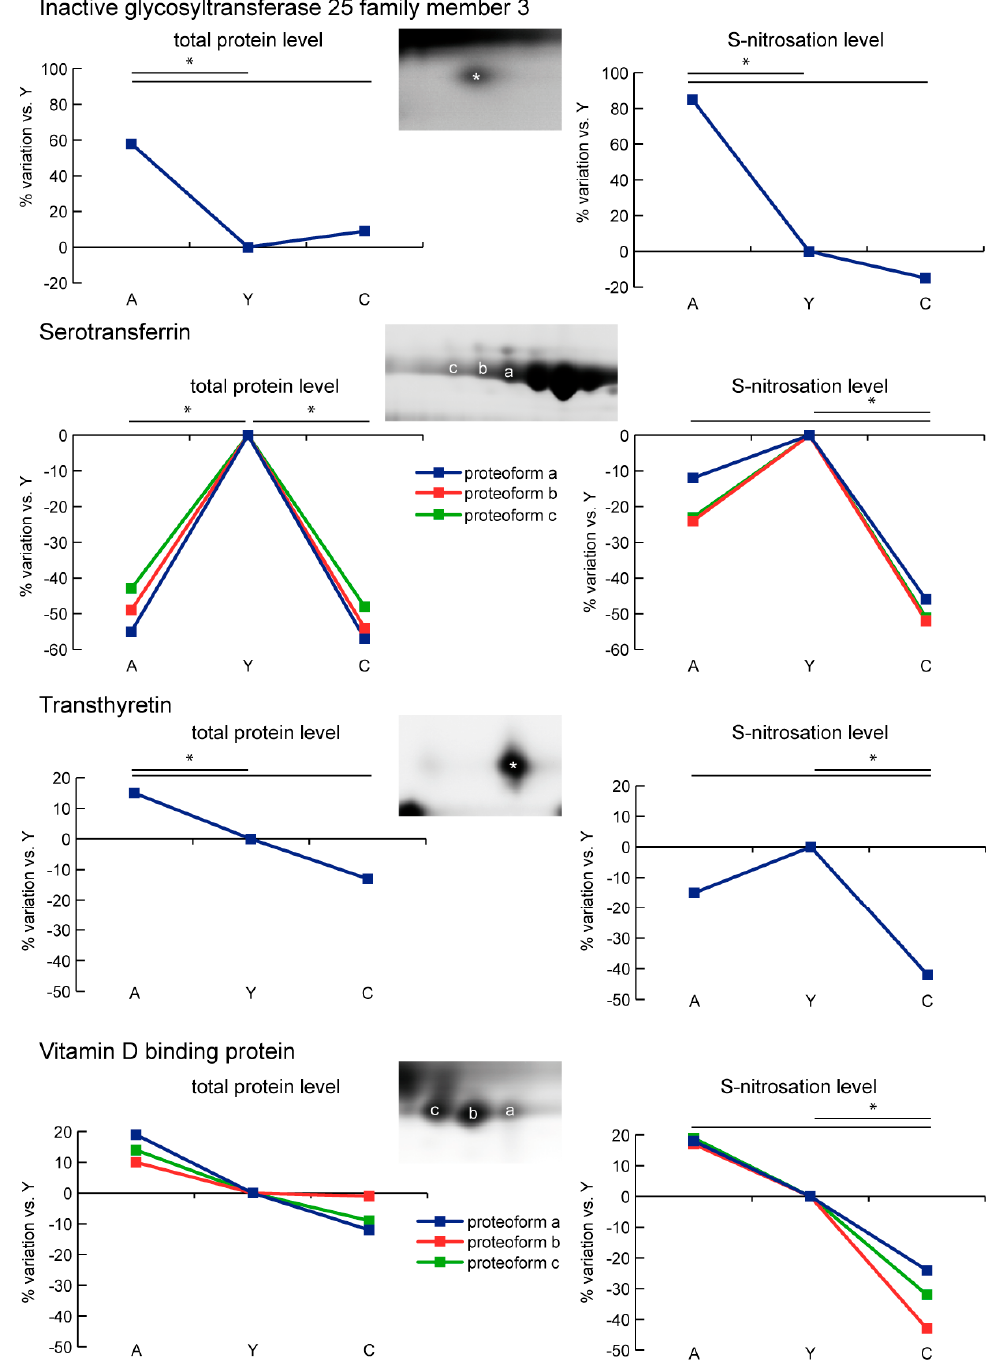
Figure 6. Line charts illustrating inactive glycosyltransferase 25 family member 3 (CERCAM), serotransferrin (TF), transthyretin (TTR), and vitamin D-binding protein (VDBP) proteoform abundance and S-nitrosation level variations (%) in sera of aged (A) and centenarian (C) compared to young (Y) women. Proteins were divided according to the statistical significance of the test (* = significant difference, ANOVA and Tukey, n = 6 (2-D DIGE) or n = 9 (Nitro-DIGE), p -value < 0.01). Three proteoforms of apolipoprotein A1 (APOA1) and immunoglobulin heavy chain alpha (IGHA1) increased in C in comparison to Y and A. The complement C4-A (C4A) resulted in an